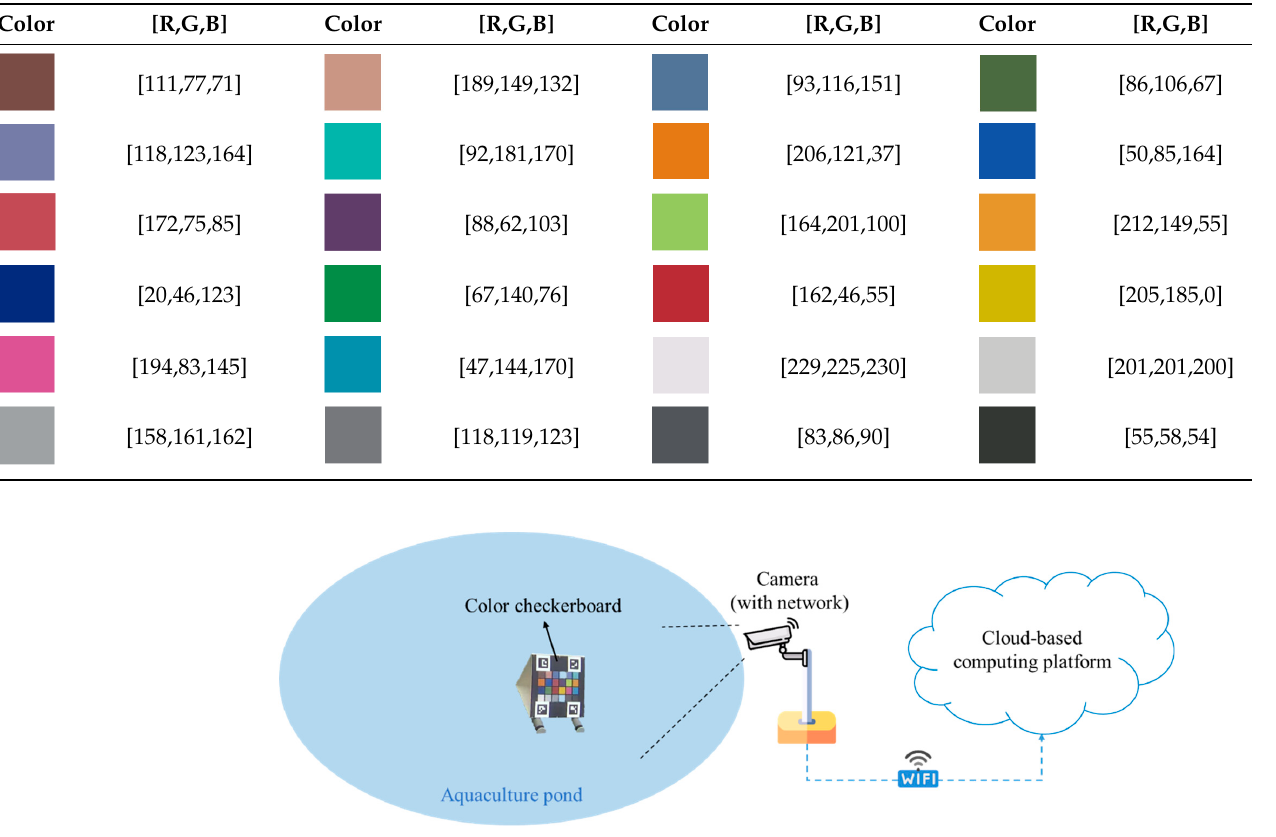
Figure 3. The proposed system established at the experimental site. Table 1. The 24 colors used in our color checkerboard.